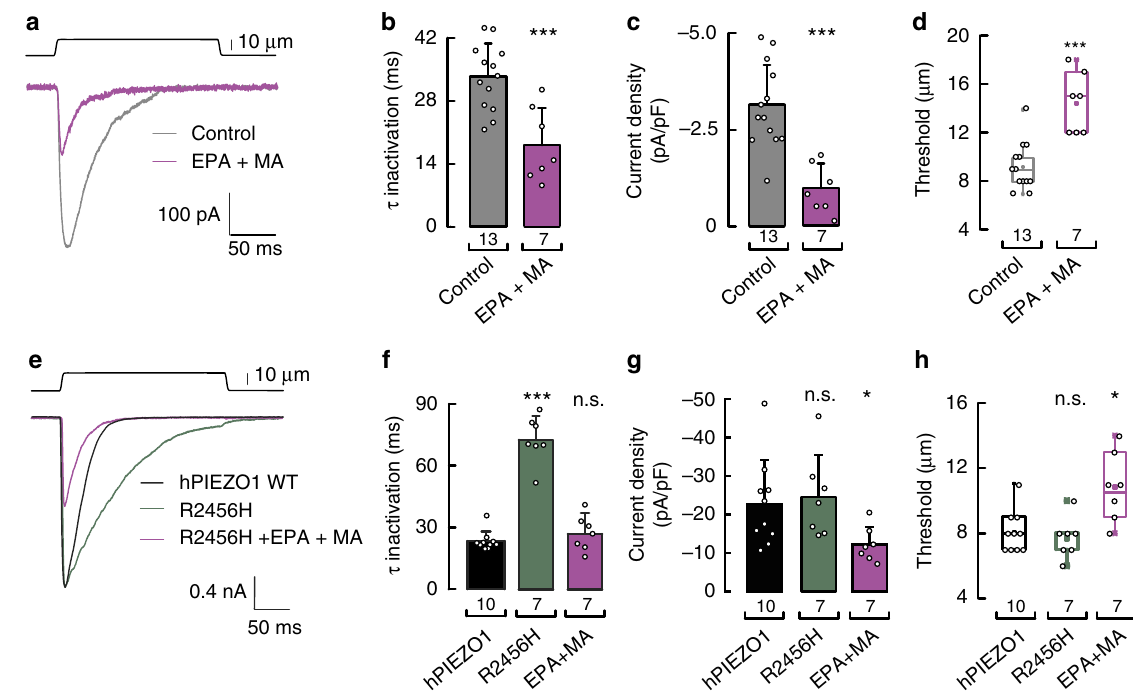
Fig. 8 EPA and MA have distinct and synergistic effects on Piezo1 gating. a Representative macroscopic current (at − 60 mV) evoked by maximum displacement of N2A cells treated with and without a mixture of EPA and MA (200 and 100 µ M, respectively). b Piezo1 time constants of inactivation elicited by maximum displacement of N2A cells treated with and without a mixture of EPA and MA. Bars are mean ± SD. One-way ANOVA and Bonferroni test. c Current densities elicited by maximum displacement of N2A cells treated with and without a mixture of EPA and MA. Bars are mean ± SD. Unpaired t -test. d Boxplots show the mean, median, and the 75th to 25th percentiles of the displacement threshold required to elicit Piezo1 currents of N2A cells treated with and without a mixture of EPA and MA. Unpaired t -test. e Representative normalized macroscopic currents (at − 60 mV) evoked by maximum displacement of N2A cells transfected with human Piezo1 wild type (WT) and R2456H, with and without a mixture of MA and EPA supplementation (200 and 100 µ M, respectively). f Piezo1 time constants of inactivation elicited by maximum displacement of N2A cells transfected with human Piezo1 WT and R2456H, with and without a mixture of MA and EPA supplementation. Bars are mean ± SD. Kruskal – Wallis and Dunn ’ s multiple comparisons